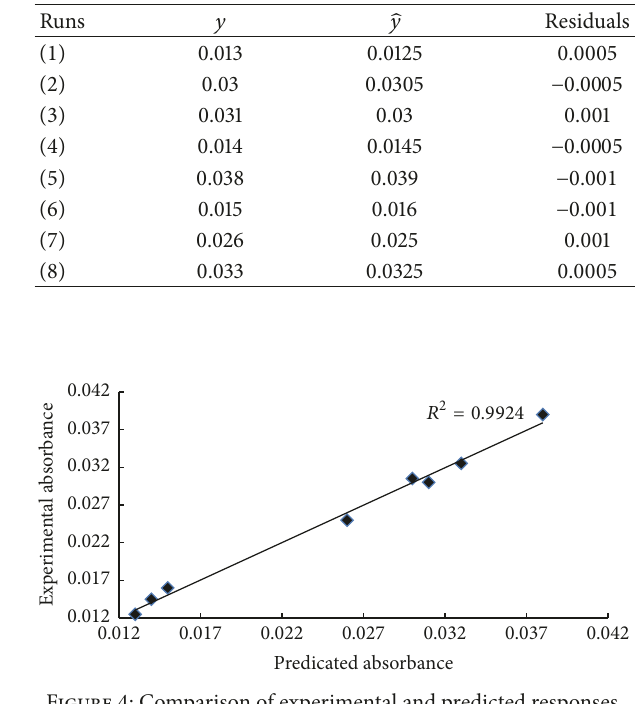
Figure 4: Comparison of experimental and predicted responses.